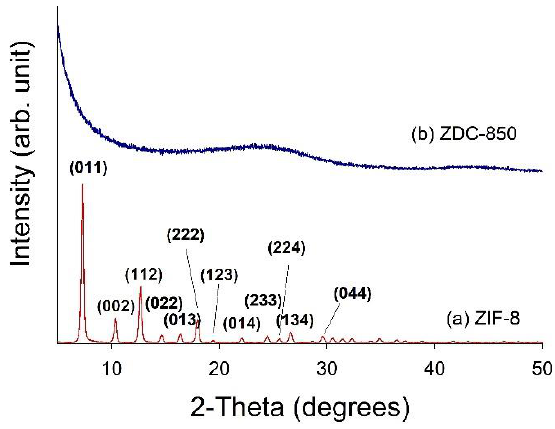
Figure 2. The XRD patterns of ZIF-8 and ZDC-850.